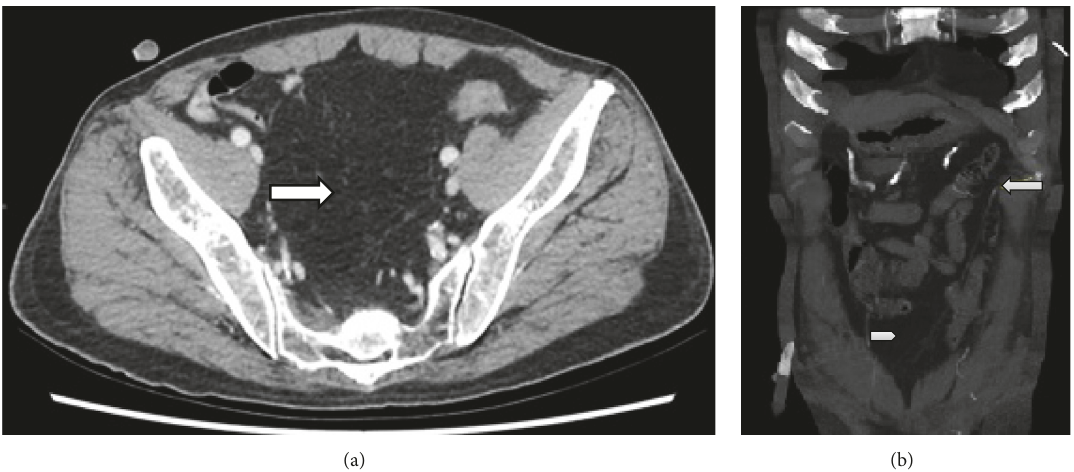
Figure 4: Case 3: Figures 4(a) and 4(b). (a) Axial CT image in the arterial phase showing a large fat-containing mass in the pelvis displacing bowel loops. No contrast extravasation is seen. (b) Coronal MIP CT images in the arterial phase showing aberrant vessel arising from the splenic artery (white arrow) and coursing obliquely from the left hypochondrium to the region of the pelvic mass (white